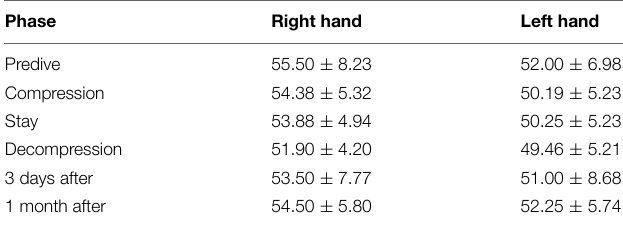
TABLE 5 | Hand–eye coordination ability across different phases of the experiment ( ¯ X ± SD, n = 4). Phase Test results ( n ) Predive 22.33 ± 2.42